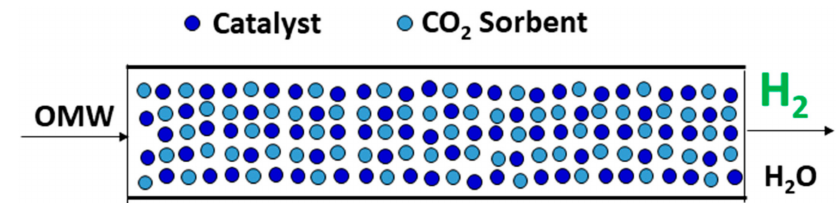
Figure 10. Scheme of the operation of the